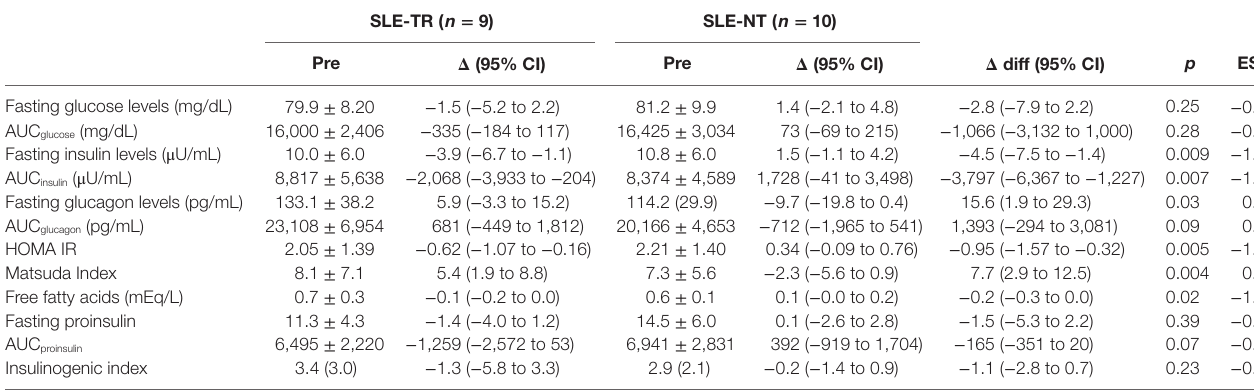
TABLE 2 | Insulin sensitivity and beta-cell function estimates in trained and non-trained SLE patients before and after the exercise intervention.